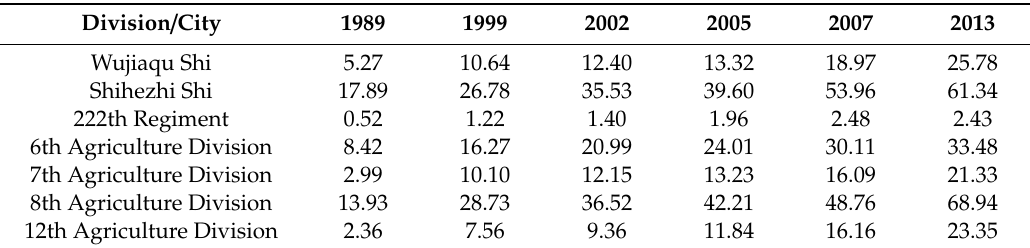
Table 6. CA of built-up areas that changed (in the XPCC Division) Unit: km 2